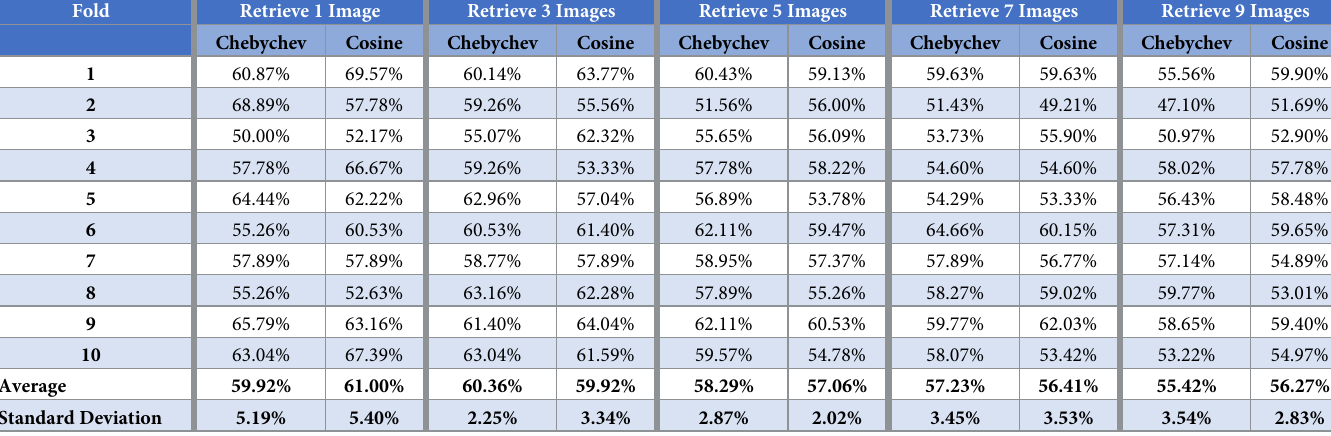
Table 5. Retrieval accuracy of 1, 3, 5, 7, and 9 CBIR image retrievals with traditional SVM classification and handcrafted features for each 10-fold. Fold